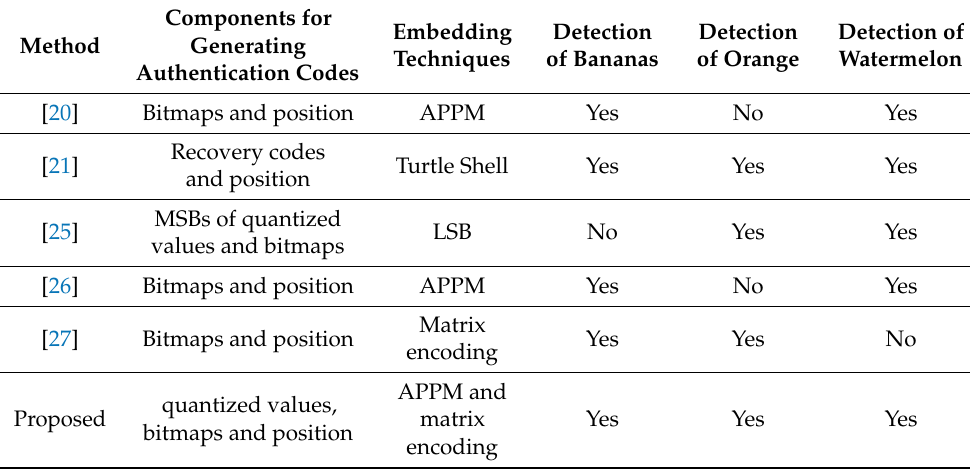
Table 5. Comparisons between prior works and the proposed